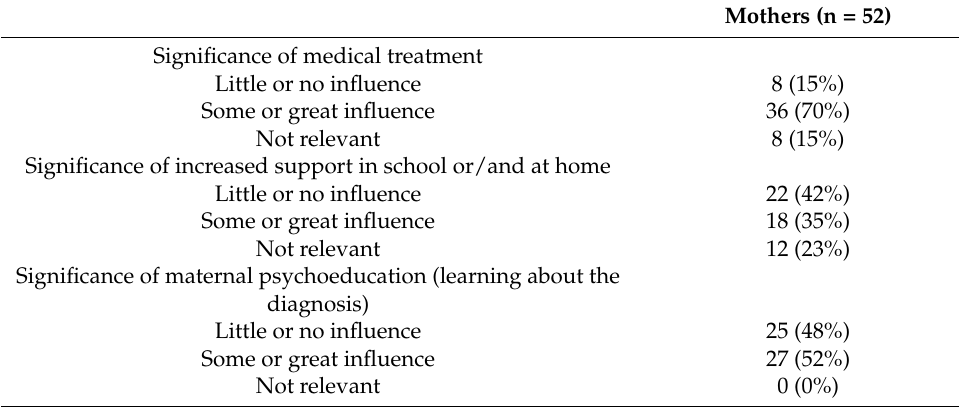
Table 3. Maternal assessment of factors of importance in the